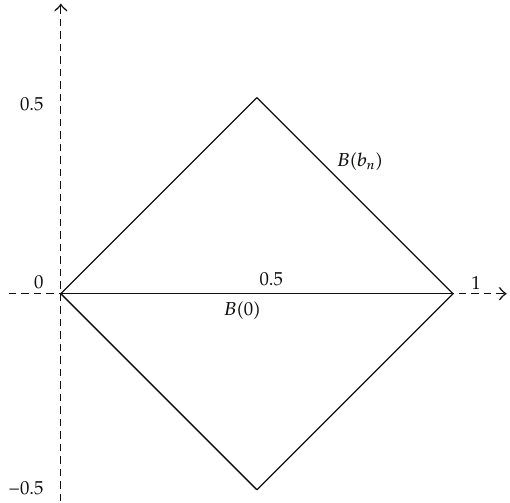
Figure 5: Spectral scales for Example